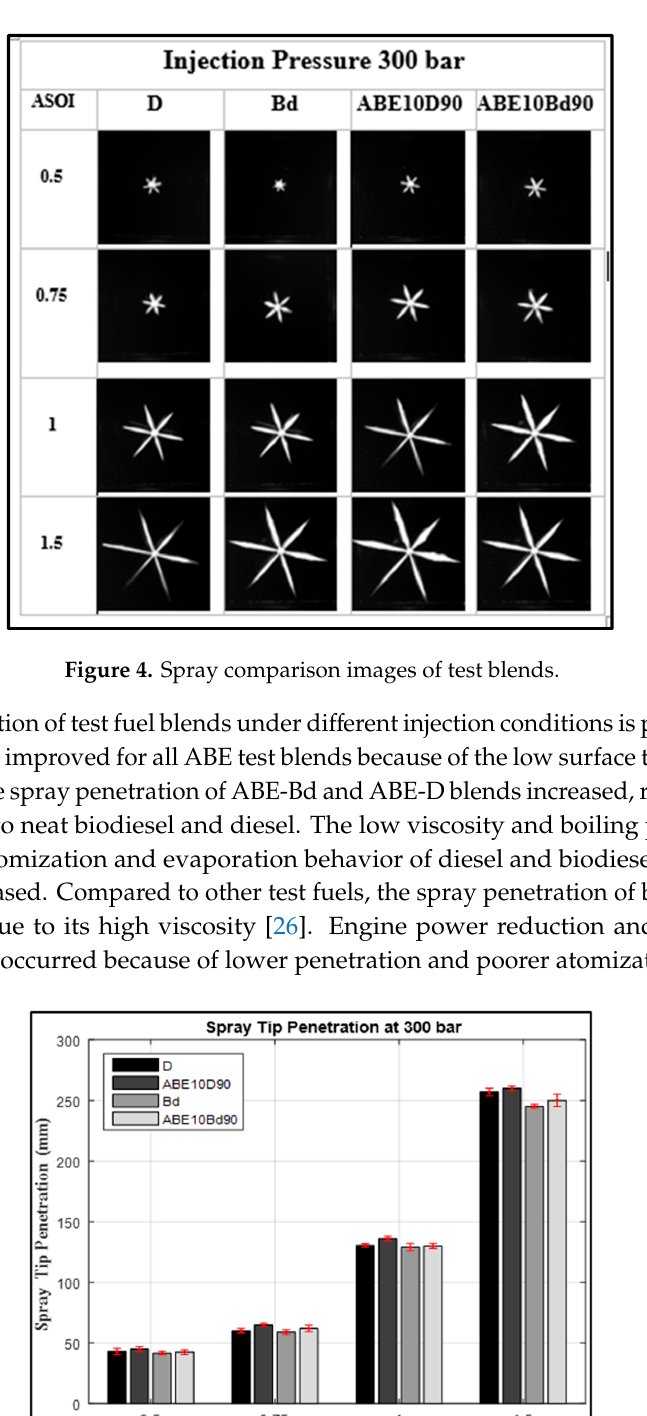
Figure 5. Spray tip penetration of test blends.